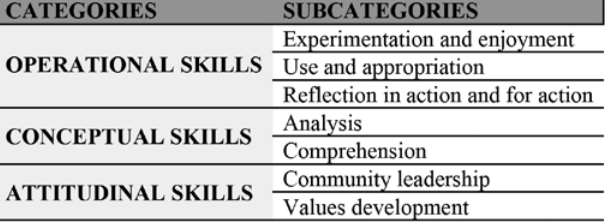
Figure 2: Category matrix of the Brazilian